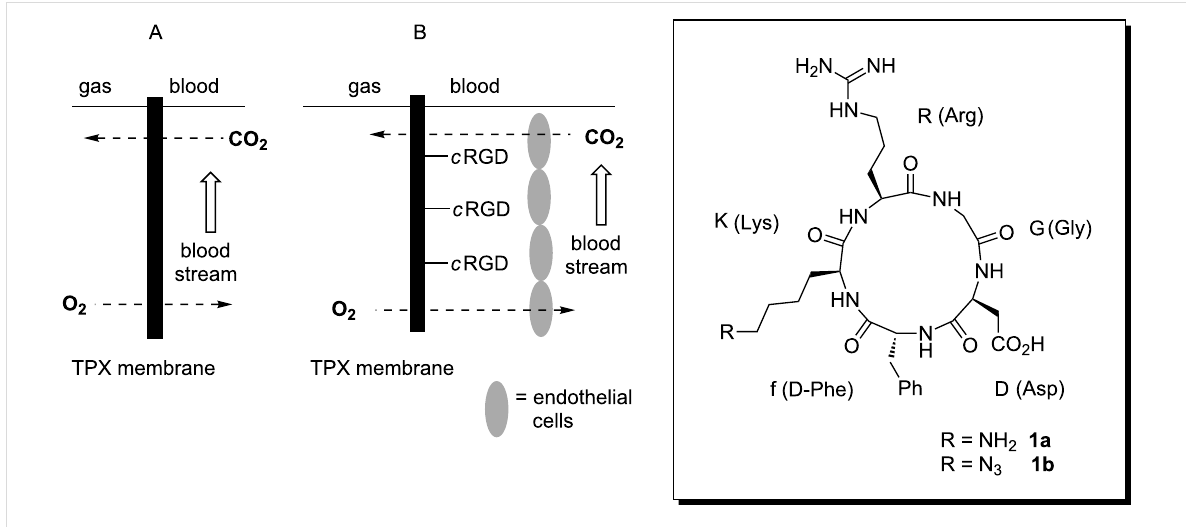
Figure 1: Schematic presentation of the artificial lung (A) and concept of membrane functionalization (B) with cyclic RGD 1b .